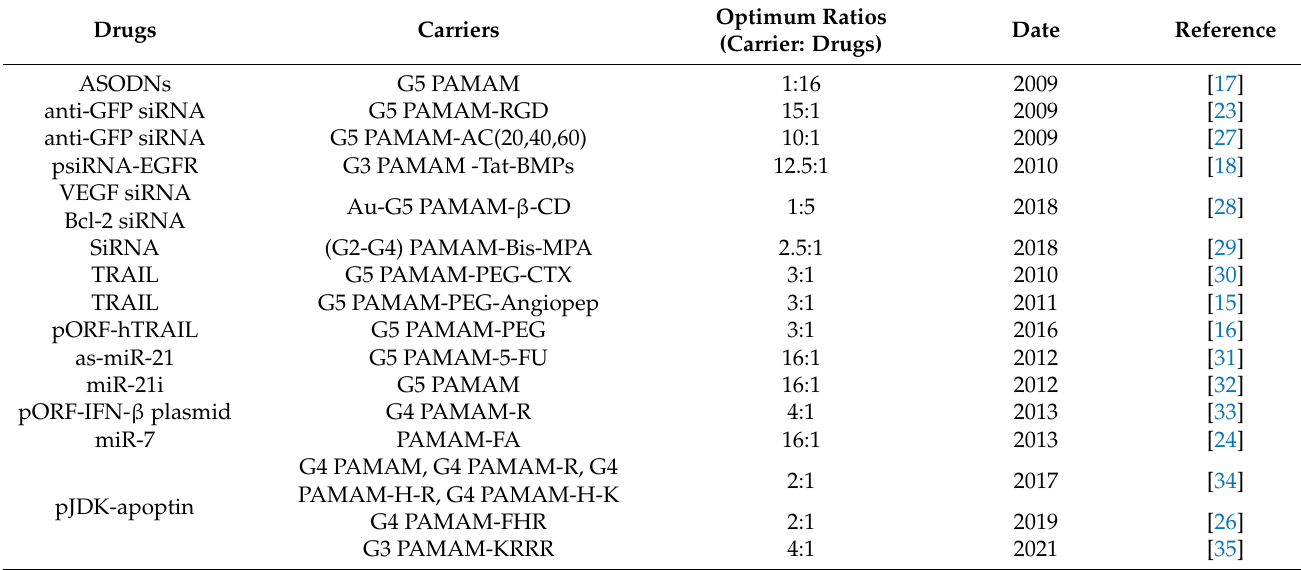
Table 2. Optimum ratios of carrier: